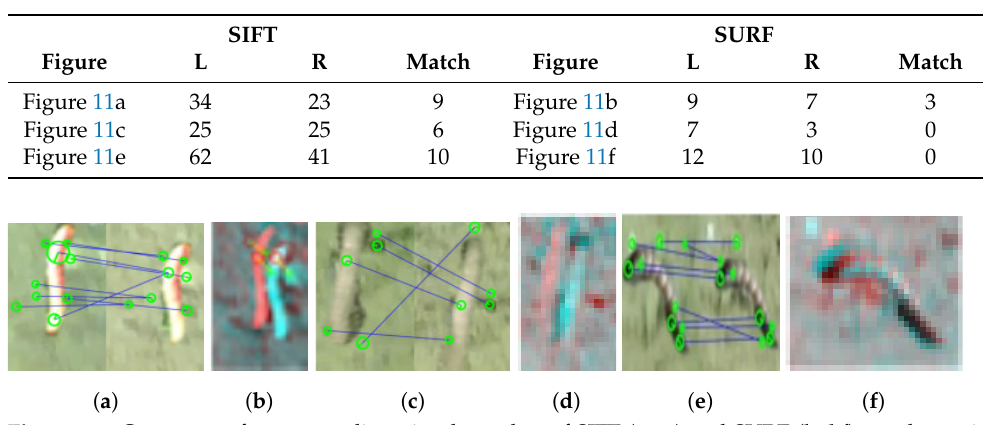
Table 3. Comparison between SIFT and SURF to match the left (L) and right (R) of the stereo camera with the insect detector output.